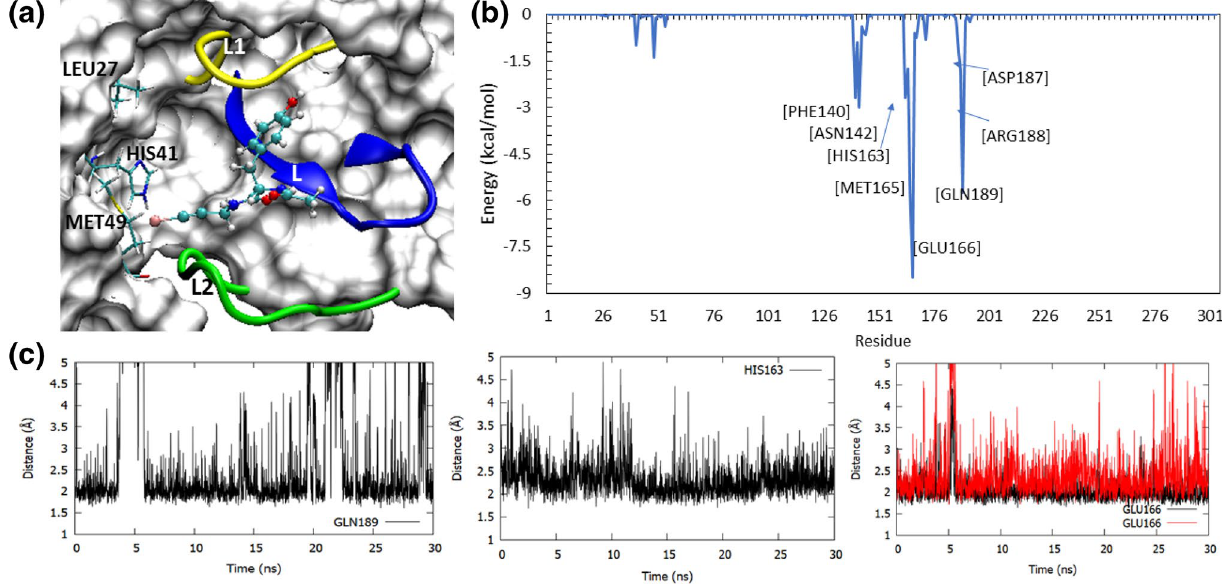
Figure 6. The binding mode of ligand in the 5RG1 complex within the catalytic site of M pro ( a ), the decomposition of key residues contributing to this ligand–receptor complex ( b ), along with the time evolution of H-bond interactions of the bound ligand with residues such as GLN189, HIS163 and GLU166 ( c ). In the ligand bind pose in this complex ( a ), the ligand is seen interacting with all the key segments in the catalytic site of M pro , which include the L1 loop, L2 loop, L β-sheet and the catalytic diad residues. Evidently, the ligand occupied the lateral pocket in the catalytic site of M pro , where it formed stable H-bonds with HIS163 residue. This binding mode was supported by other key residues such as GLN189 and GLU166, as seen in the pairwise decomposition plot ( b ). The molecular graphic used in this figure was generated using VMD 1.9.3 63 ( a ) while the plots were generated using GNUplot (v5.2 patchlevel 8 http:// www. gnupl ot. info/) ( c ) and Microsoft Excel 365 ( b ) (https:// www. office. compounds, the ligand co-crystallized in the PDB structure 5RGV, 2-(isoquinolin-4-yl)- N -phenylacetamide, also had a high affinity of − 22.65 kcal/mol; but, in this structure, it was an isoquinoline group that formed a H-bond with HIS163 and occupied the lateral pocket. This shows that the lateral pocket can engage different moieties such as pyridine, phenol and isoquinoline groups. A previous study 81 noted that the H-bond interactions between different covalent and non-covalent ligands with two conserved hydrophobic residues HIS163 and GLU166 in M pro and suggested a possible role for these residues in viral polypeptide cleavage process. The other molecules (in Fig. 4) in the binding affinity range of − 15 and − 22 kcal/mol include ligands that formed stable interactions with the ‘L2’ loop, ‘L’ β-sheet and also with ‘L1’ loop, but, they did not occupy the lat- eral cavity. For example, the 1-methyl-3,4-dihydro-2 ~ {H}-quinoline-7-sulfonamide ligand (in 5R81), interacted with the ‘L2’ loop through H-bonds with GLN190 and GLY192, and with the ‘L’ β-sheet through hydrophobic interactions with MET165 and GLU166, in addition to the interactions with HIS41 (supplementary figure, SFig. 12). However, this ligand did not engage with the lateral pocket and consequently had a weaker binding affinity of − 18.3 kcal/mol. In a similar nature, ligands including 5-(1,4-oxazepan-4-yl)pyridine-2-carbonitrile (5RF6), N -[(4-cyanophenyl)methyl]morpholine-4-carboxamide (5REE), 2-(4-methylphenoxy)-1-(4-methyl- piperazin-4-ium-1-yl)ethenone (5RE9), N -(4-methoxypyridin-2-yl)-2-(naphthalen-2-yl)acetamide (5RGY), and N -(2-phenylethyl)methanesulfonamide (5R7Y) interacted with different segments within the binding site without occupying the lateral cavity and all of them displayed weaker binding affinity toward M pro . While our MM-GBSA analyses suggested that ligand engagement with the lateral pocket in M pro improved the binding affinity, the ligand complex of 5RF7 was an exception. The ligand in this complex, 1-(4-methylpiperazin-1-yl)- 2-(1H-pyrrolo[2,3-b]pyridin-3-yl)ethan-1-one, contained a pyrrolopyridine moiety that was indeed bound in the lateral pocket of M pro and formed H-bonds with HIS163. However, the methylpiperazine group remained flexible and formed only transient H-bonds with the key residues such as GLY143, ASN142 and GLU166 (sup- plementary figure, SFig. 13). It can be noted that although this ligand did not make stable interactions with the key residues in the catalytic pocket such as MET49, GLY143, SER144, MET164, and GLU166 (SFig. 13b), it still had an affinity of ~ − 16.1 kcal/mol that was mainly due to the stable engagement of the ligand with the lateral pocket in M pro . Again, this highlighted the important role of the lateral pocket in the ligand M pro interactions. In order to verify the stability, molecular interactions and binding affinity of the ligand–M pro complexes over a long simulation time, we extended the MD simulation of the selected systems for upto 100 ns. All the parameters for the extended MD remained the same as used in the 30 ns long simulation. Only those complexes that remained stable and had a binding affinity score lower than − 20 kcal/mol (in Fig. 4a) during the initial shorter simulation (of 30 ns) were subjected to the longer MD runs. This choice was made as the compounds that either unbound or displayed weaker binding affinity to M pro during the 30 ns trajectory may not benefit from